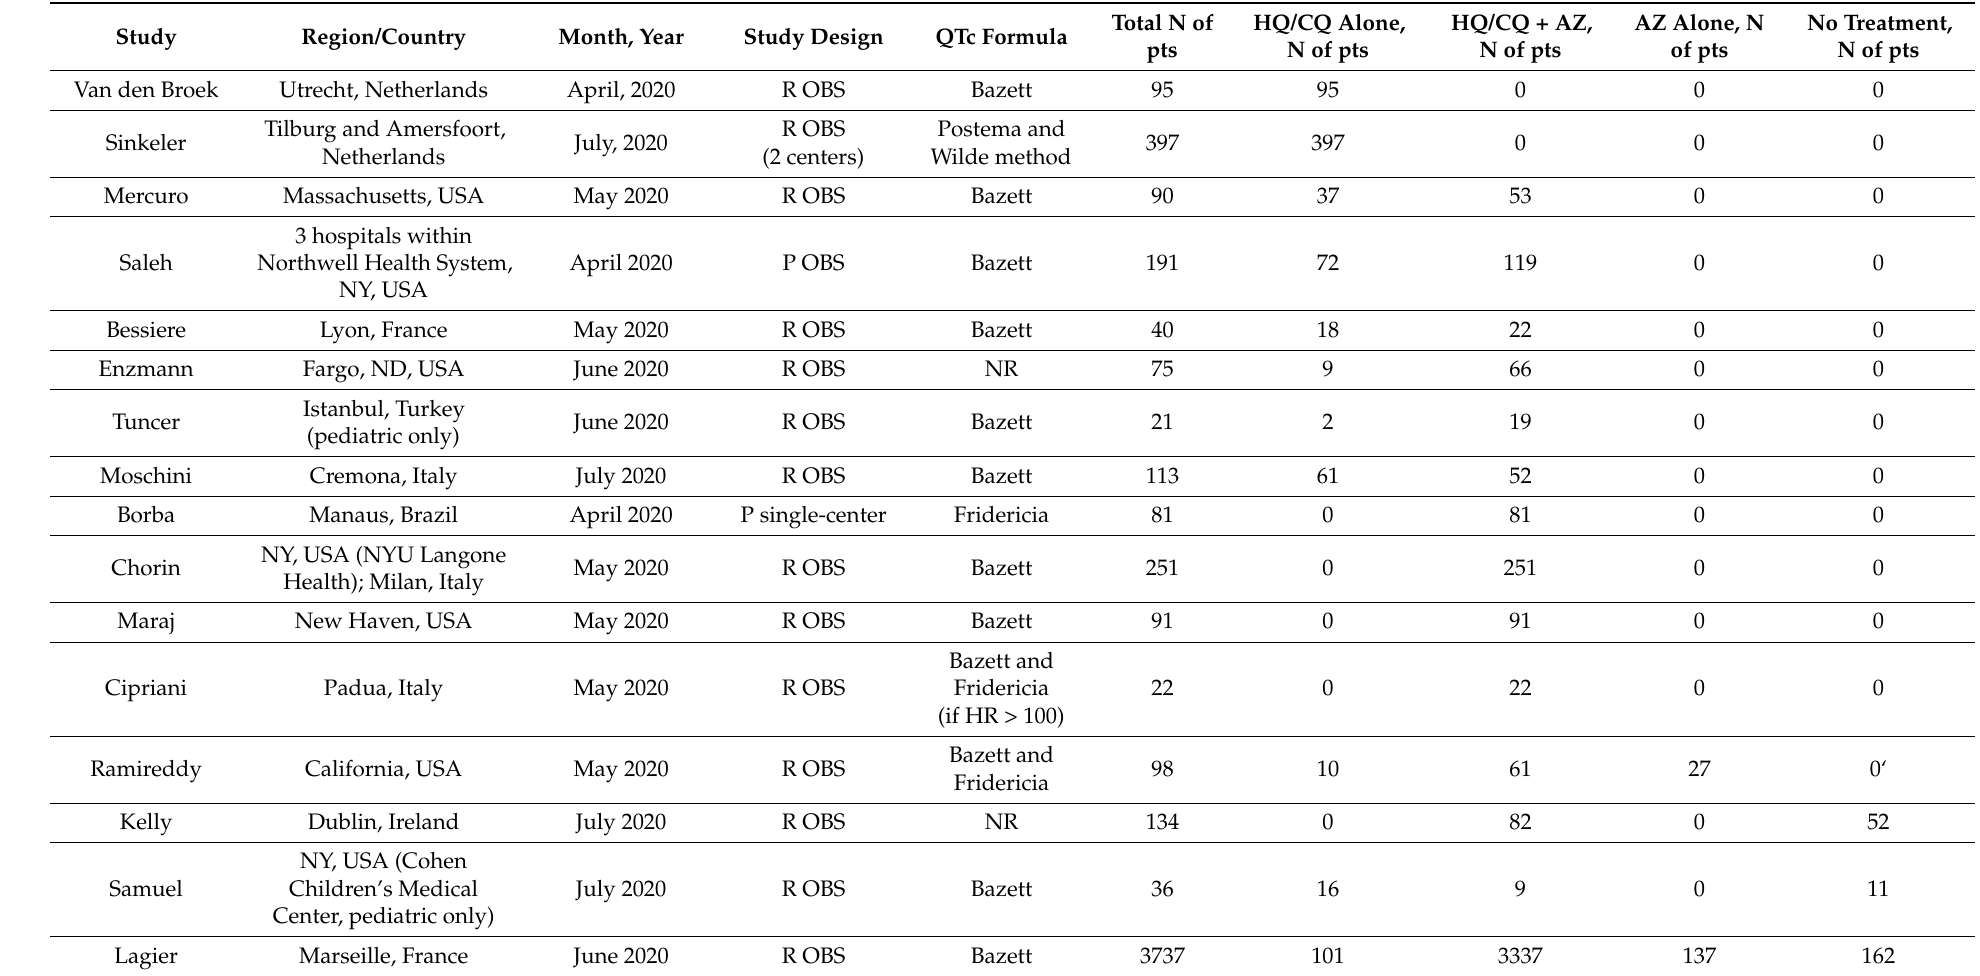
Table 1. Characteristics of included